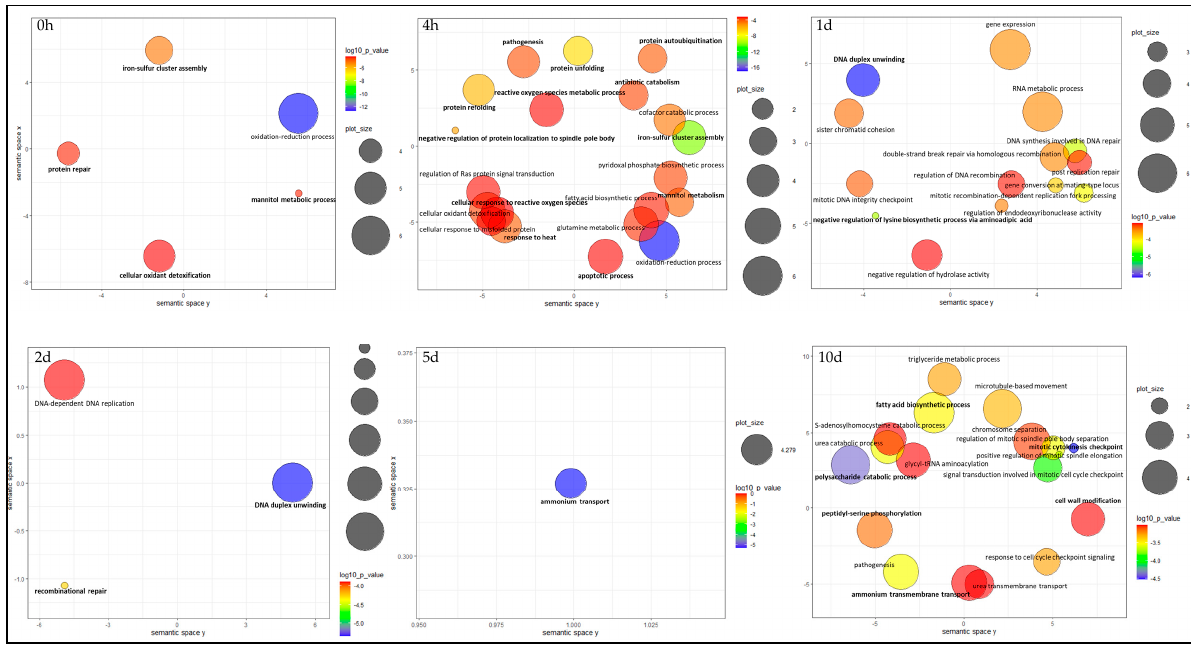
Figure 5 Figure 5. Enrichment analyses of GO terms related to upregulated biological processes of SE at six different stages of symbiotum establishment; summarized and visualized using REVIGO. Circles indicate GO terms and are plotted according to semantic similarities to other GO terms. Circle size is proportional to the frequency of the GO term, while colour indicates the log10 P -value (red higher, blue lower). Adjoining circles are most closely related. Cluster representatives are given in bold black